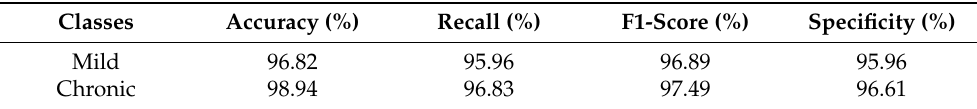
Table 5. Performance evaluation of anemia severity detection module in 3-TierDCFNet during